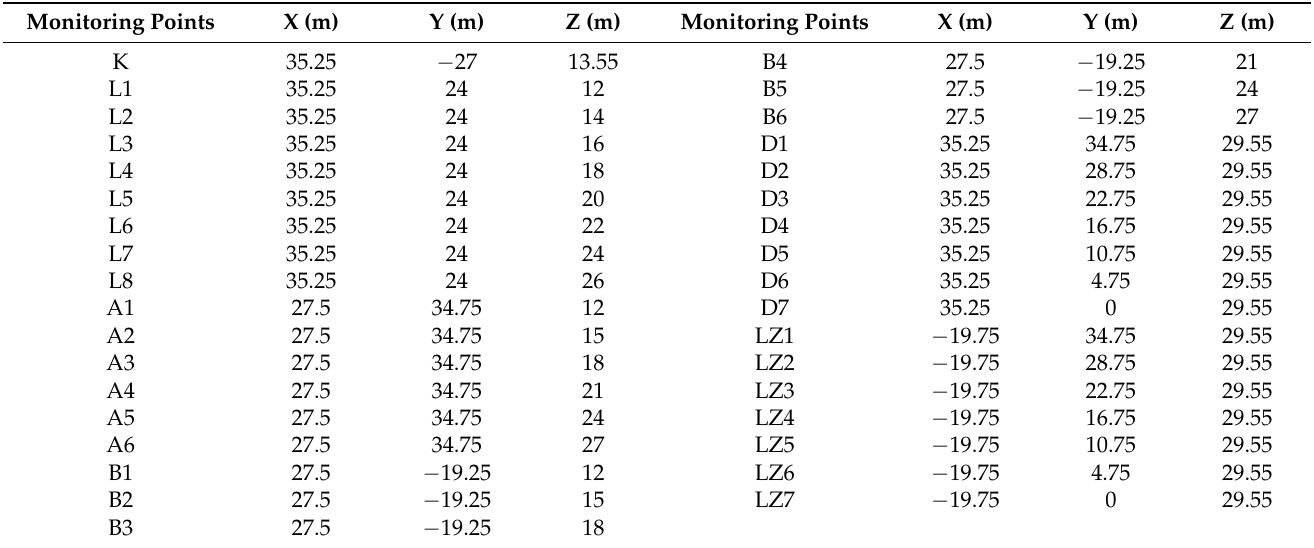
Table 4. The coordinates of the monitoring